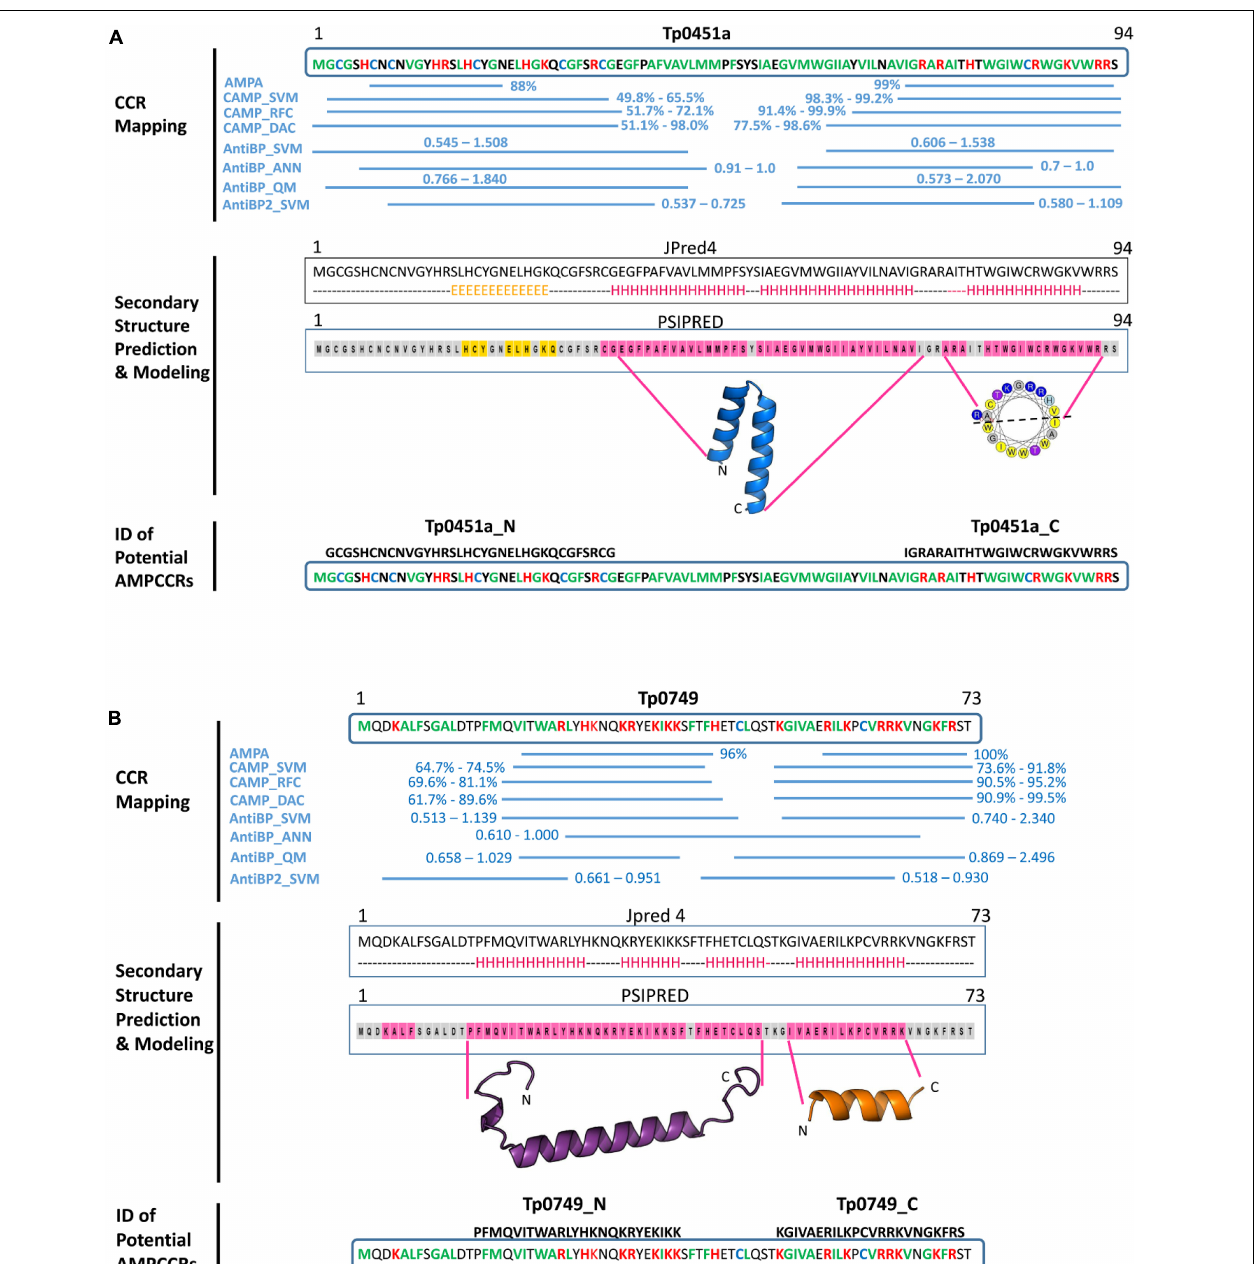
FIGURE 5 | In silico identification of potential T. pallidum AMPCCRs. The critical core regions of two candidate AMPs, (A) Tp0451a and (B) Tp0749, were predicted using our bioinformatics pipeline. The first step of the pipeline involved CCR mapping (A,B , top): four prediction servers [AMPA (one algorithm), CAMP (three algorithms), AntiBP (three algorithms), and AntiBP2 (one algorithm)] were used to identify the amino acid boundaries of potential antimicrobial active regions (critical core regions, CCRs). High probability/scoring regions predicted by at least three of the four servers are shown with their corresponding probabilities (AMPA and CAMP algorithms) or scores (AntiBP and AntiBP2 algorithms). Hydrophobic residues: green; Positively-charged residues: red; Cysteines: blue. In the second step of the pipeline, secondary structure analyses and modeling were performed ( A and B panels, middle): secondary structure analyses of the full-length proteins were performed using Jpred 4 (H: alpha helix; E: beta strand; dashed line: coiled) and PSIPRED (pink highlight: alpha helix; orange highlight: beta strand; gray highlight: coiled). HeliQuest was used to generate helical wheel diagrams for potential alpha helices (yellow: hydrophobic residues; purple: serine or threonine; blue: positively charged residues: gray: glycine or alanine). Structure modeling using Modeller generated a confident model for the central region of Tp0451a (residues E36-I71), but confident models were not generated for the N- or C-terminal regions. Structure modeling using a combination of PEP-FOLD-2, Swiss-Model, Molsoft ICM, and Modeller generated models for the N- and C-terminal regions of Tp0749 (residues P14-S48 and I52-K65, respectively). Together, these findings allowed for the identification of two potential critical core regions within the N-terminus (Tp0451a_N and Tp0749_N) and C-terminus (Tp0451a_C and Tp0749_C) of Tp0451a and Tp0749 ( A and B panels,